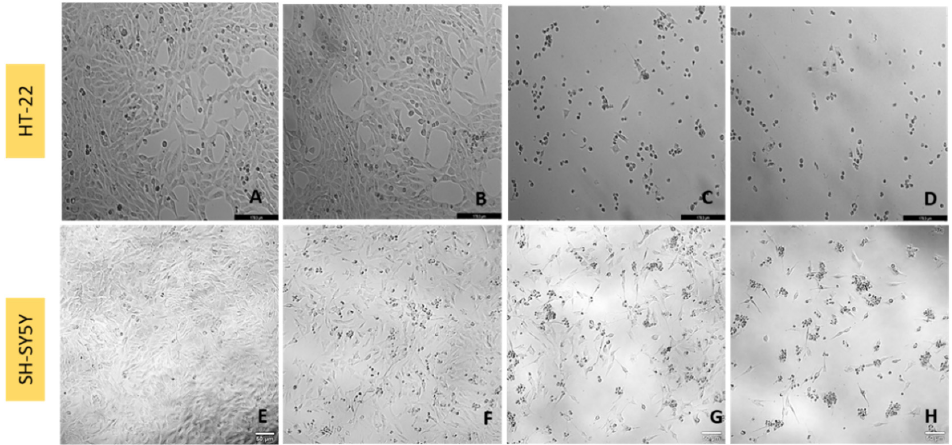
Figure 2. Representative images (100 × total magnification) of HT-22 and SH-SY5Y cells after incubation of increasing concentrations of H 2 O 2 . Cells were treated with ( A , E ) vehicle (0.1% sterilized water) ( B , F ) H 2 O 2 50 μ M, ( C,G ) H 2 O 2 150 μ M, ( D , H ) H 2 O 2 300 μ M.